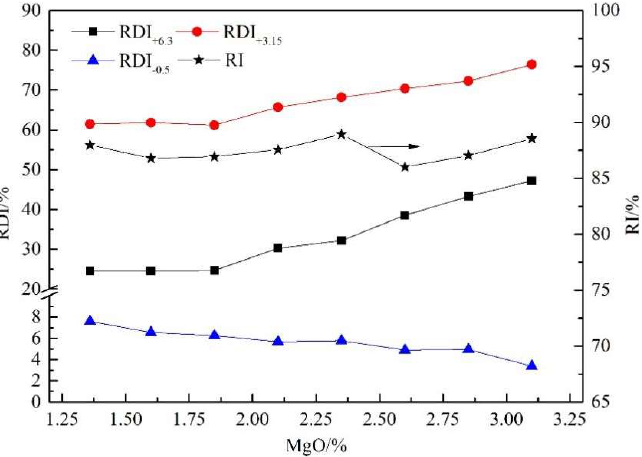
Figure 3. Effect of MgO content on the RDI and RI of sinter in COREX shaft furnace.